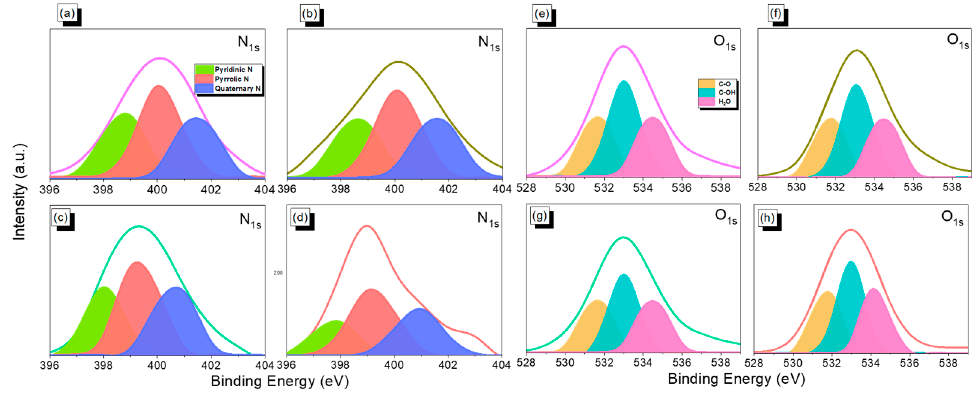
Figure 3. XPS fitting curves of N 1s ( a – d ) and O 1s ( e – h ) orbitals for An-CTF-10-400, An-CTF-20-400, An-CTF-10-500, and An-CTF-20-500. Table 2 . XPS data of N 1s and O 1S orbitals of synthesized An-CTFs.